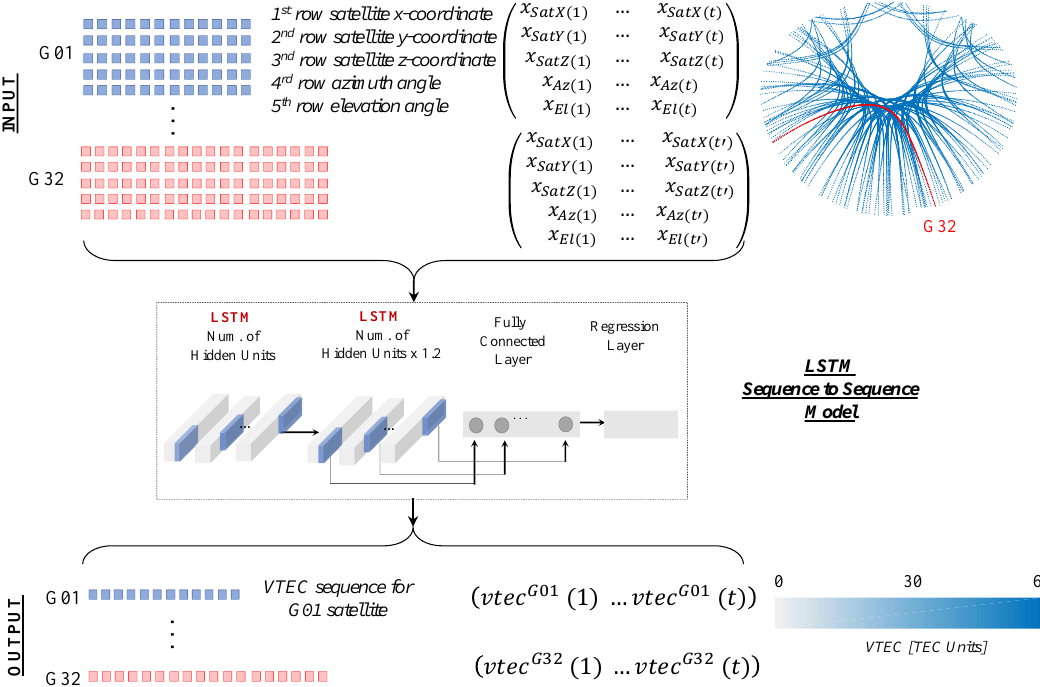
Figure 3. This proposed LSTM architecture for TEC sequence ( vtec s ( 1 ) ... vtec s ( t ) ) prediction. The deep learning structure consists of two stacked LSTM layers. The proposed LSTM is a sequence to sequence regression model. The output is TEC sequences from GNSS observations at a given station which are of varying length (e.g., t , t’ ) and the input has as features the satellite position vector [ x SatX x SatY x SatY ], the azimuth ( x Az ) and the elevation angles x El of the satellite direction from the receiver site. For example satellite G32 with a trajectory as illustrated in the figure with red line, is visible from station bor1 for about 5 h, thus the input sequence for G32 satellite has length 600 values, for the measurements sampling rate at 30